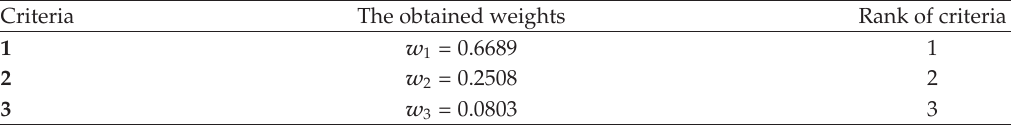
Table 4: The result of proposed method for Example 3 (cid:2) see Section 4.3 (cid:3) .